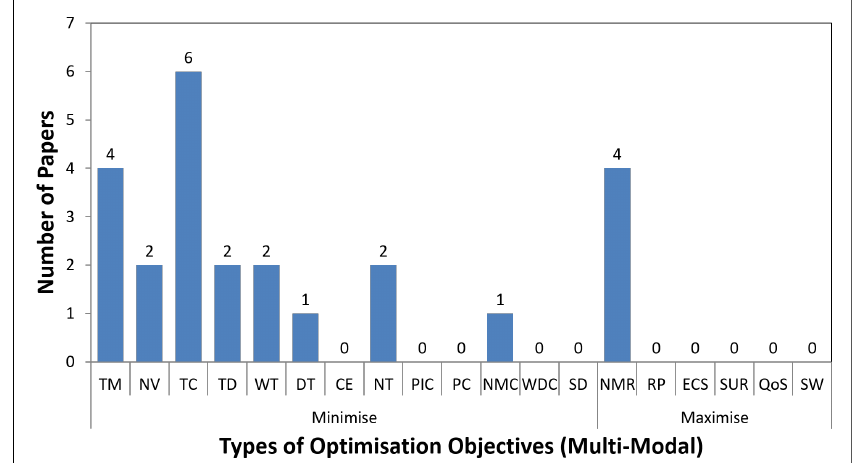
Figure 16. Distribution of Papers based on the Optimisation Objectives: